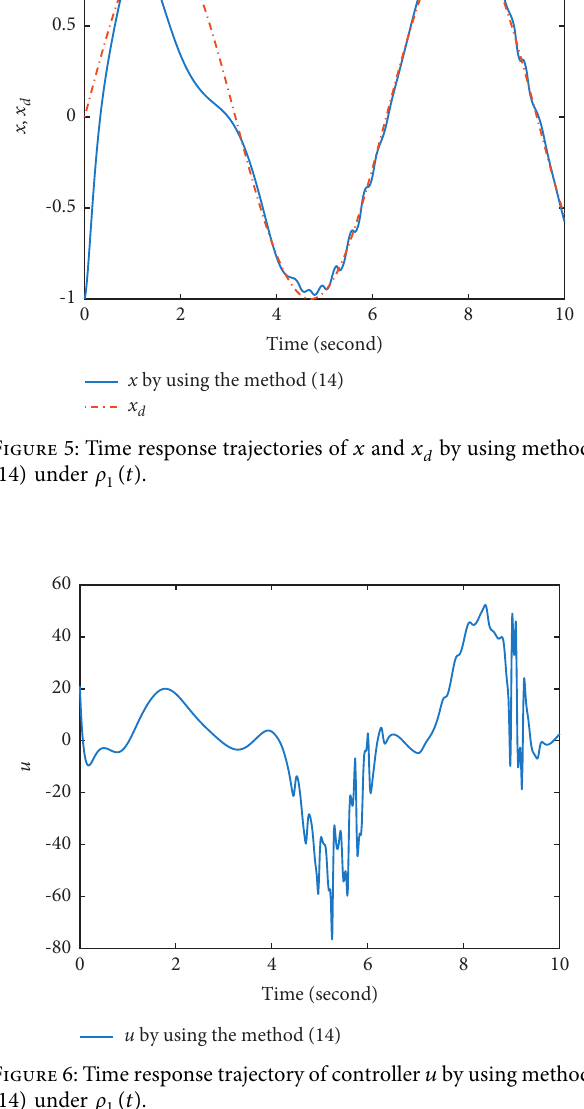
d by using method